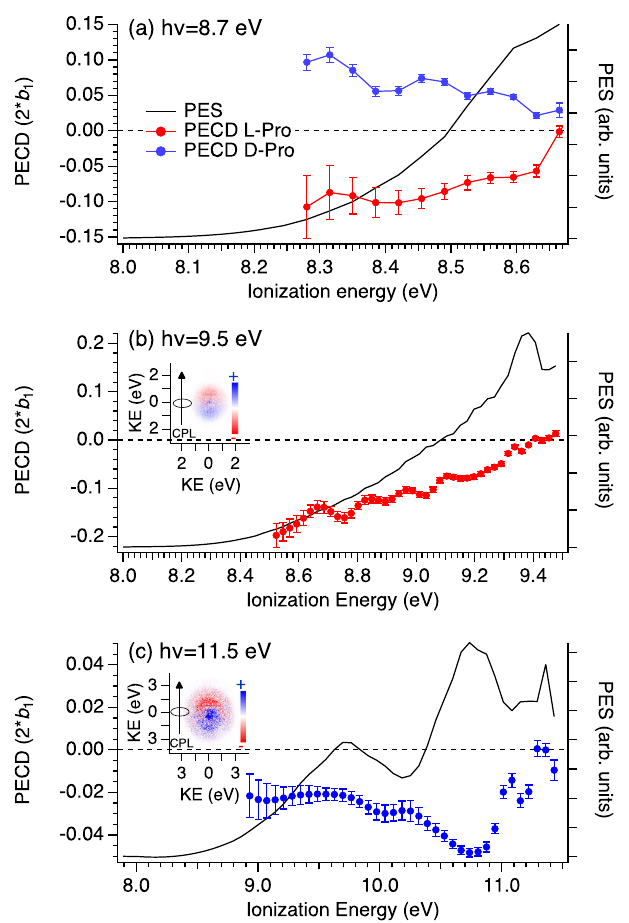
Fig. 4 PES (solid curves) and PECD (symbols with error bars) obtained with D - (blue) and L - (red) proline enantiomers, produced in TD 415 conditions. The data are extracted from a given pair of electron images recorded with left- and right- circularly polarized light (CPL) using photon energies of a 8.7 eV; b 9.5 eV; c 11. 5 eV. PECD points corresponding to a relative PES intensity below 10% of the maximum signal are not shown, due to their increasing error bars when normalized by the PES intensity. Error bars correspond to statistical (standard deviation) errors. The images include electrons coincident with formation of all masses associated with the ionization of Pro ( m / z 115 + m / z 70). PES pro fi les can be understood as relative cross-sections for ion formation and at a given ionization energy will correspond to formation of a speci fi c excited state of the ion; however, as photon energy is increased, the kinetic energy for electrons produced for a given ionization energy (state) will be likewise increased. A clear dependence of b þ 1 f g with both the ion state and the associated electron 1 kinetic energy is thus observed. Note the satisfactory and expected L/D mirroring in panel a . Inserts show raw difference photoelectron velocity map images obtained by subtracting left- and right-CPL measurements. The images show a forward/backward asymmetry with respect to the CPL propagation